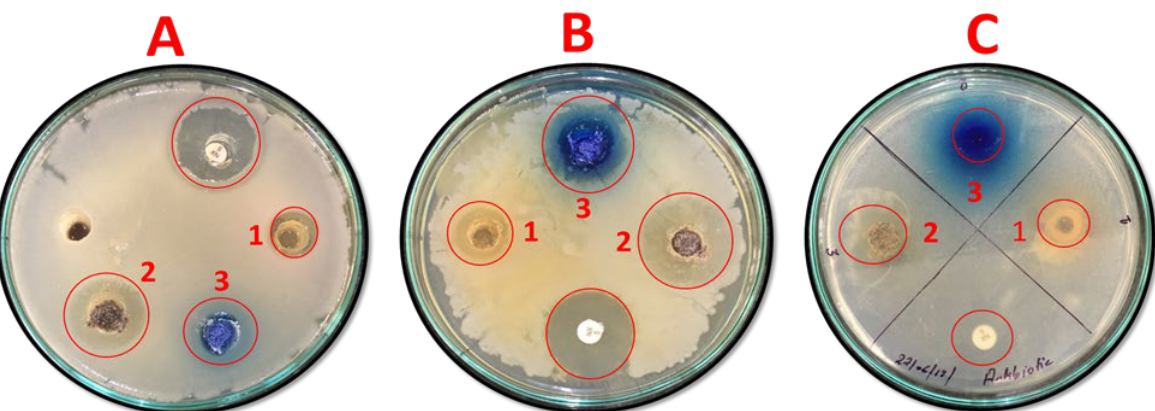
Figure 9. MHA plates having antibacterial activity of test sample 1(AuNPs), 2(HA/Au nanocomposite) and 3(dye adsorbed waste HA/Au nanocomposite) against bacterial strains, M. luteus ( A ) S. aureus ( B ) and P. aeruginosa ( C ). Table 5. Zone of inhibition of test sample 1(AuNPs), 2(HA/Au nanocomposite) and 3(Dye adsorbed waste HA/Au